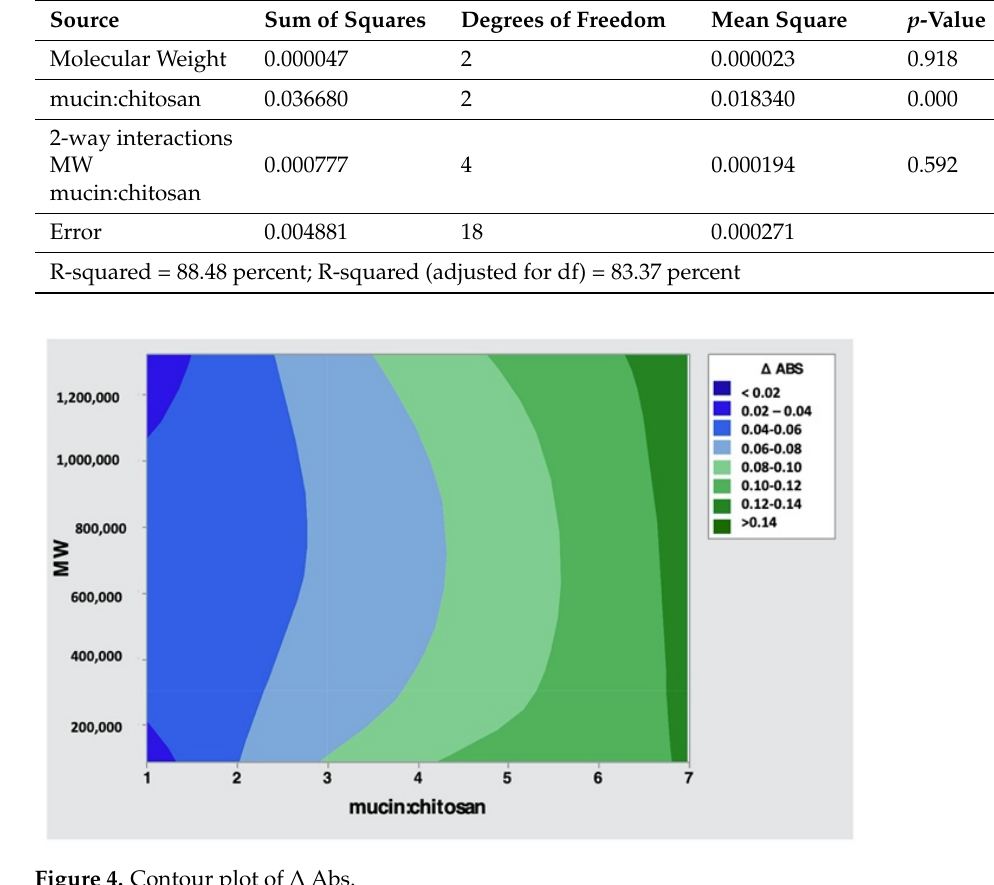
Figure 4. Contour plot of ∆ Figure 4. C ontour plot of Δ Abs.